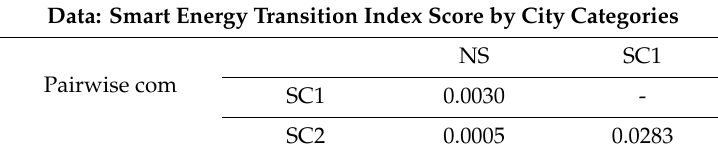
Table 10. Pairwise comparisons using the Wilcoxon rank-sum